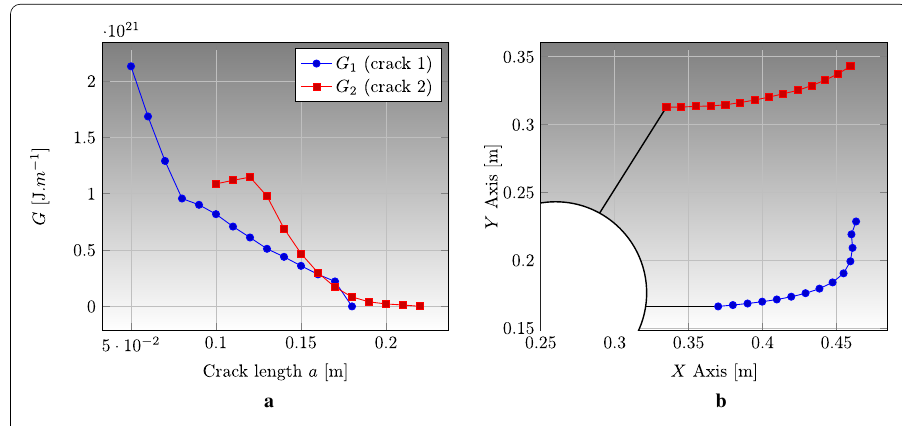
a b Fig. 25 Crack growth in plate with two circular holes and multiple cracks: a energy release rate G . , b cracks path